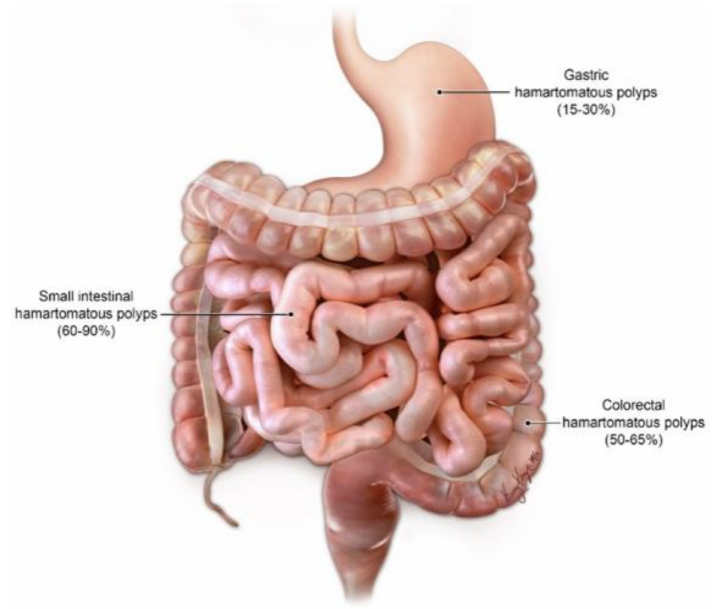
Figure 4. Distribution of GIT polyps in